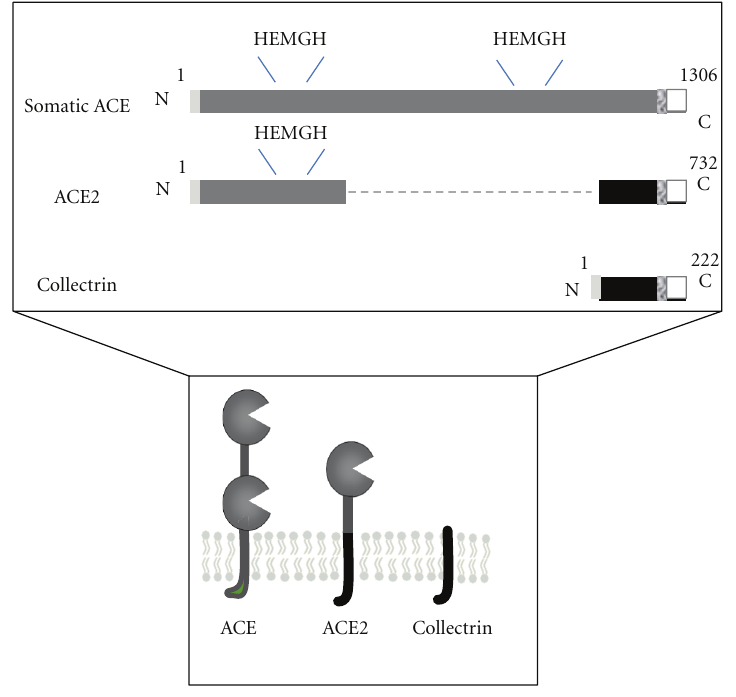
Figure 2: The domain structure and membrane topology of somatic ACE, ACE2, and collectrin. Each protein is a type I integral-membrane protein with an N-terminal ectodomain, a transmembrane region, and a short C-terminal cytoplasmic tail. Residue numbers are indicated. Both ACE and ACE2 contain zinc-binding motifs (HEMGH), which form the active sites of the enzyme: somatic ACE has two active sites whereas ACE2 only has one. Collectrin contains no catalytic residues. ACE2 is homologous to the N-terminal ectodomain of ACE but has no homology with its C-terminal cytoplasmic domain. Instead, it shares a number of residues with the intracellular domain of collectrin. Signal peptide in light grey; transmembrane domain in textured